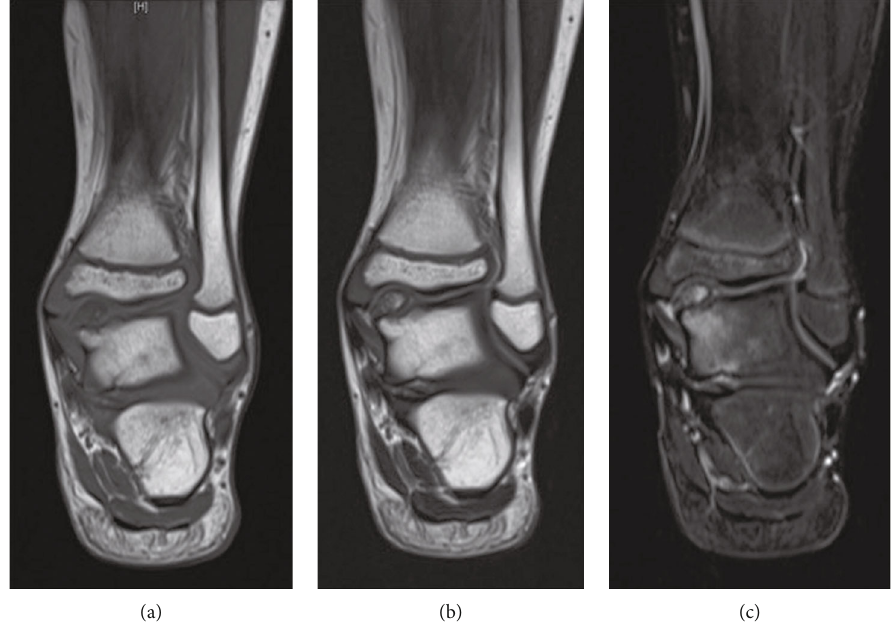
Figure 2: Magnetic resonance (MR) image: (a) coronal T1-weighted image, (b) T2-weighted image, and (c) short T1 inversion recovery (STIR) image. T1- and T2-weighted MR images showed an intra-articular oval mass of a low intensity partially with high intensity and with high intensity on STIR image. The di ff use STIR high-intensity lesions were con fi rmed on the protuberance from the talus and the area underneath